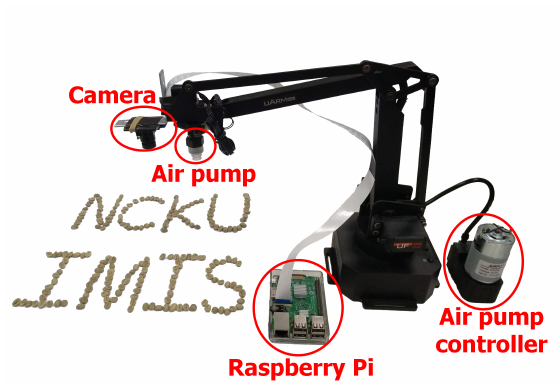
Figure 11. Illustration of experimental equipment. A robotic arm with a camera on the end effector for removing defective coffee beans is used in this